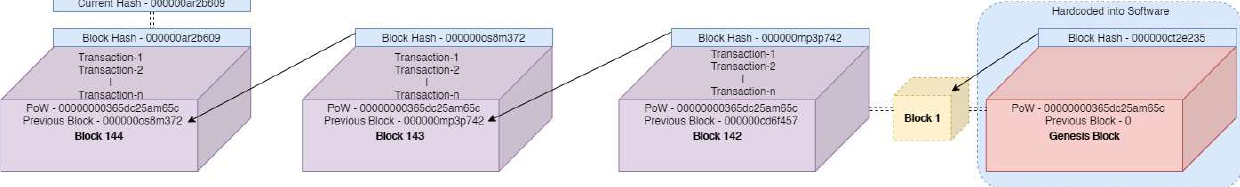
Figure 2. Blockchain Structure; PoW—proof of work.